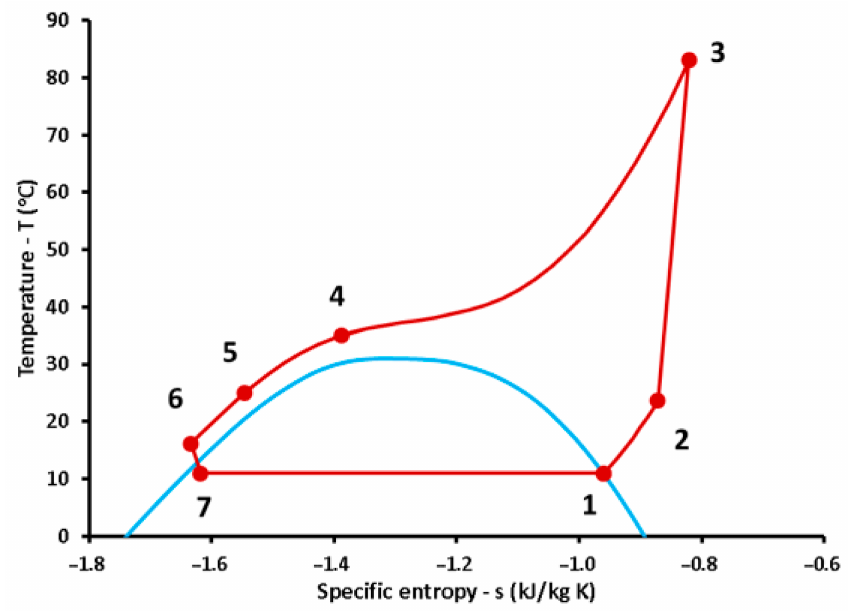
Figure 2. Pressure–specific entropy depiction of the heat pump cycle for the default scenario.